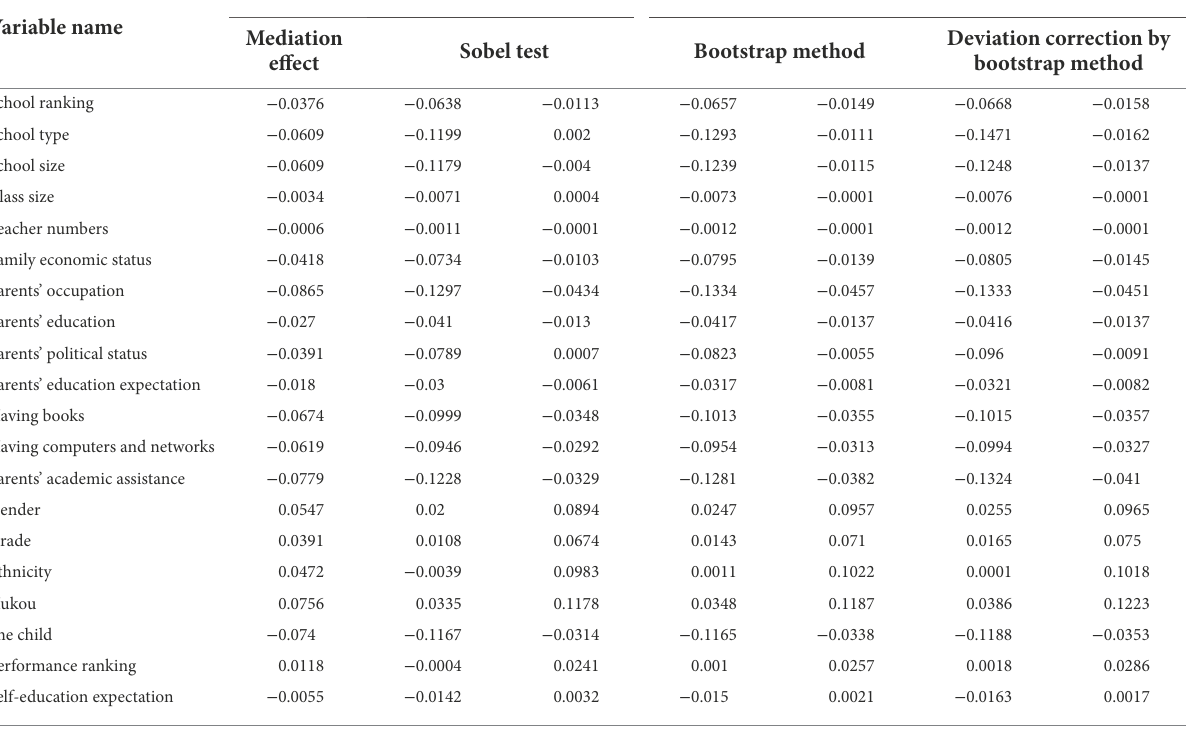
TABLE 3 Mediation effect of shadow education (cognitive